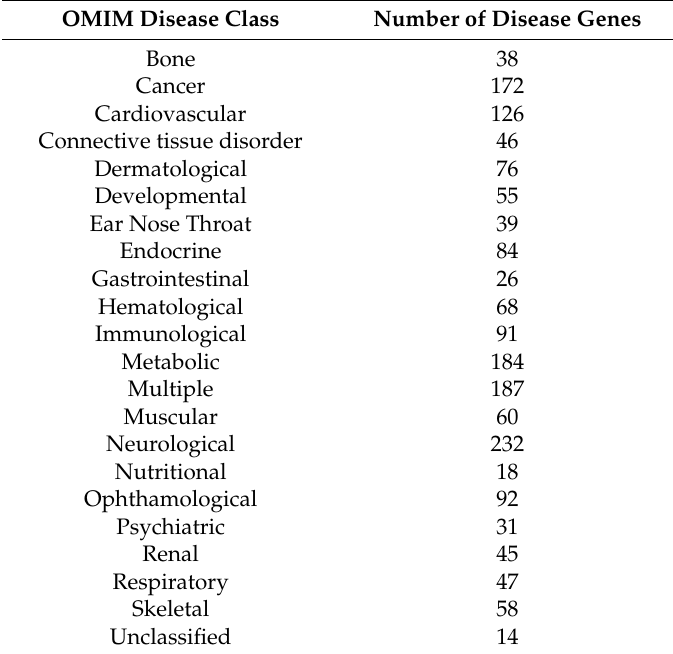
Table 1. Number of disease genes of 22 Online Mendelian Inheritance in Man (OMIM) disease